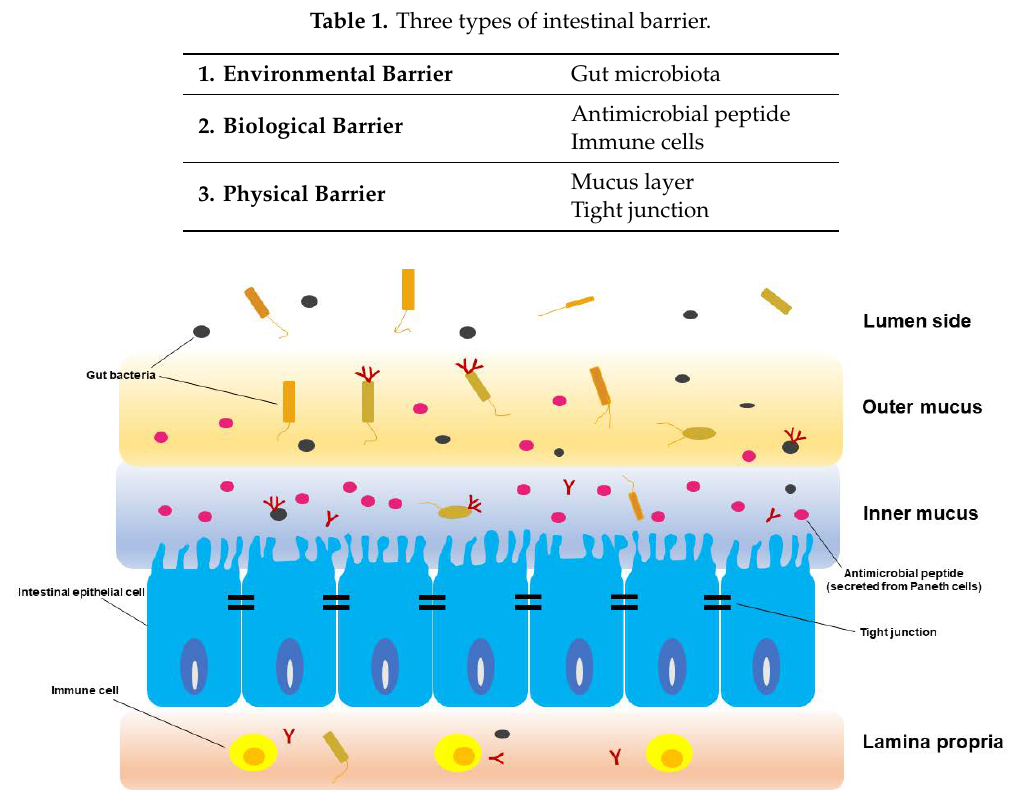
Figure 1. Defensive mechanism of intestinal barrier .